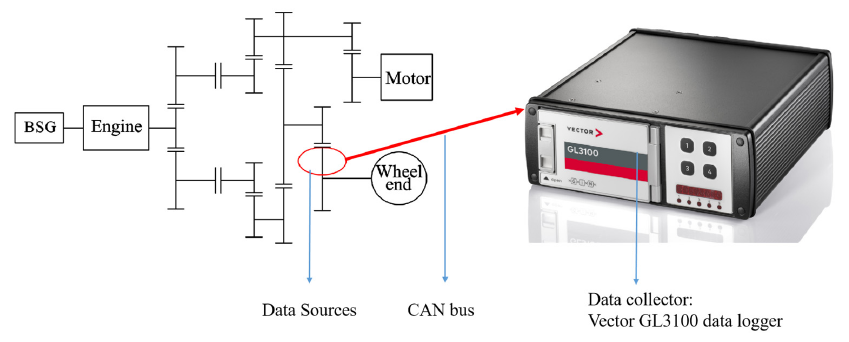
Figure 1. Test data acquisition equipment.